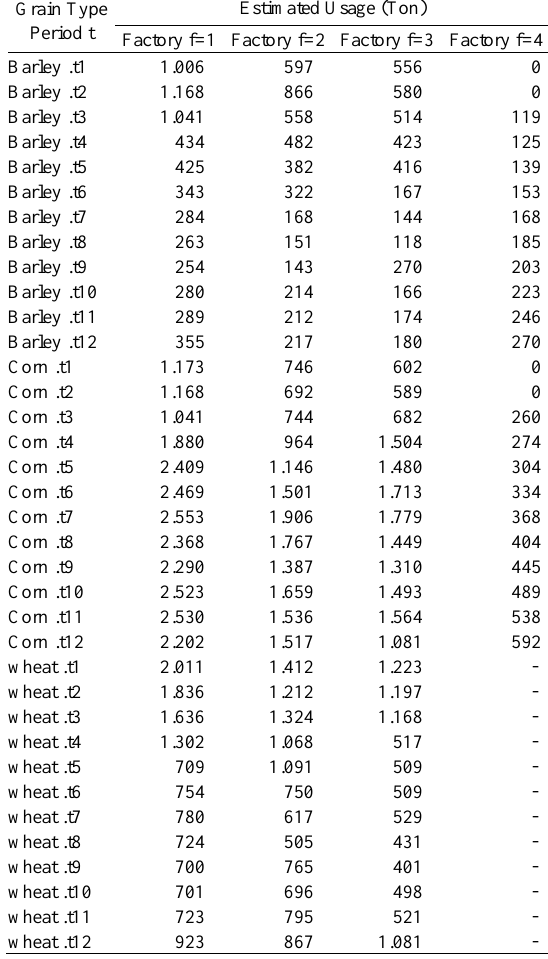
Table 5. Estimated grain